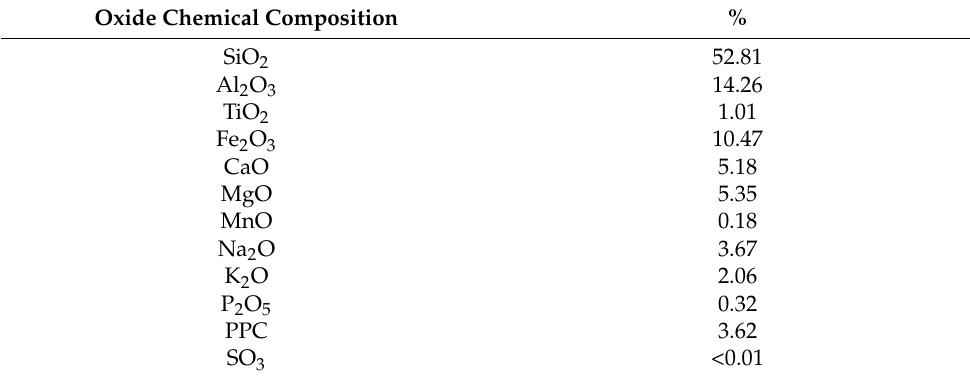
Table 3. Oxide chemical composition for the